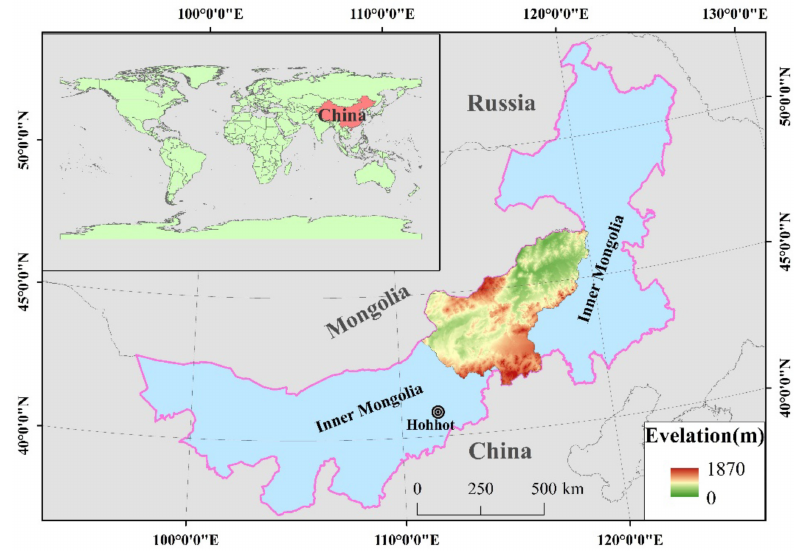
Figure 1. The location of the study areas—Xilingol League.